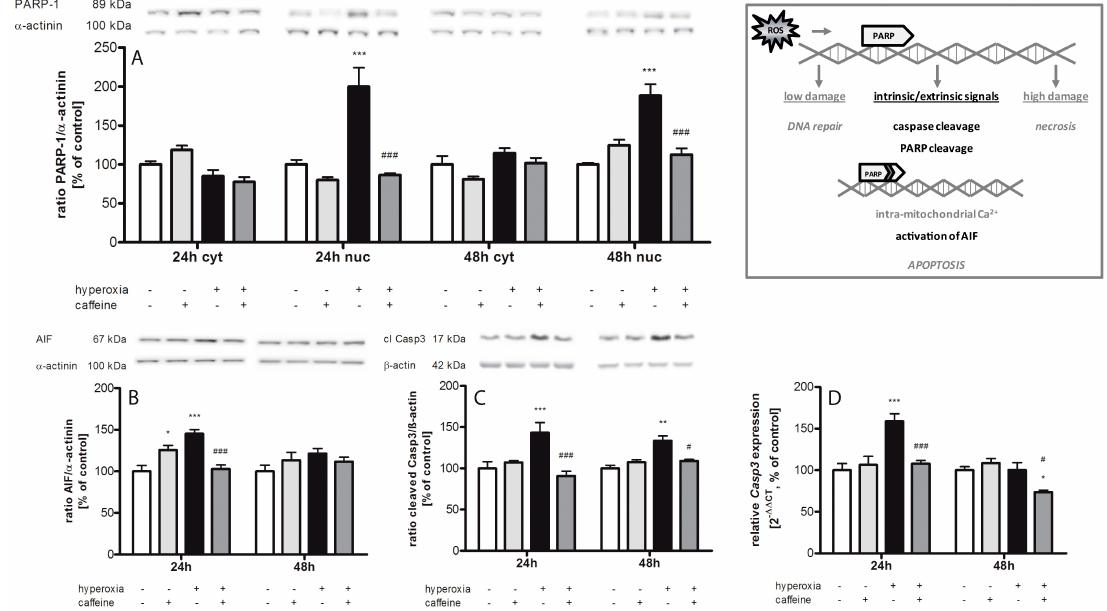
Figure 5. Caffeine inhibits hyperoxia-induced apoptotic key mediators. ( Box ) ROS-induced DNA damage activated PARP-1, an initially repair enzyme. PARP-1 is a substrate of caspase-3, a